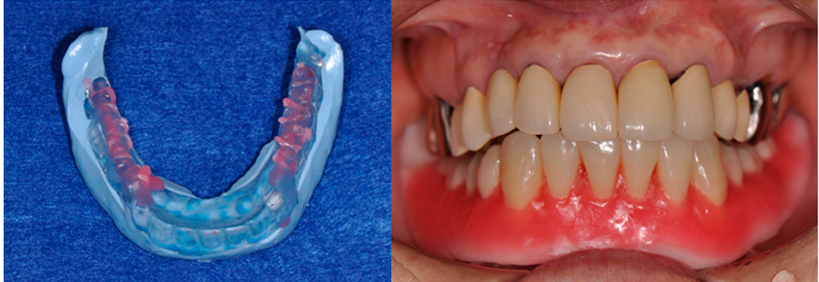
Figure 8. The completion of final impression and interocclusal records using the duplicated denture ( Left ). Wax lower denture was fabricated according to the morphology of duplicated denture ( Right ).